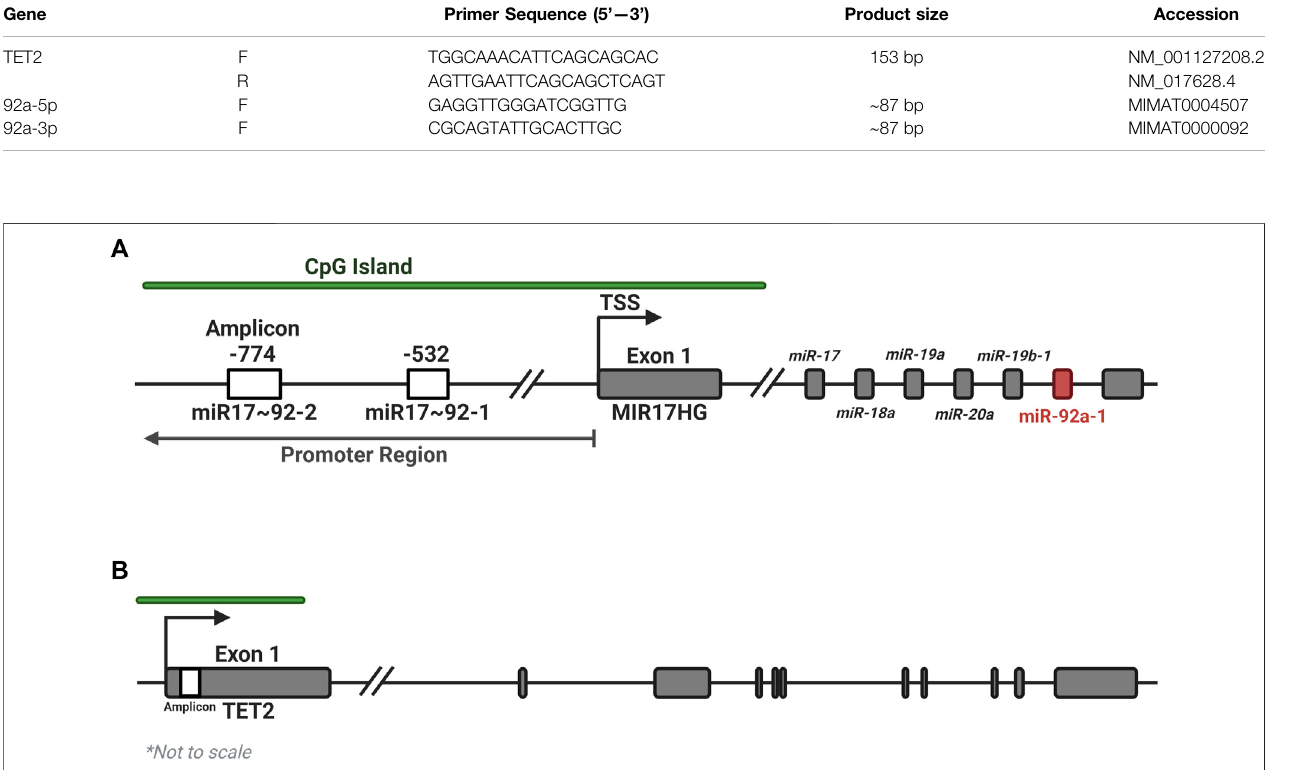
FIGURE 1 | Location of amplicons for the MIR17HG and TET2 methylation assays. Two regions of four CpGs each were identi fi ed within the promoter CGI of the MIR17HG gene (A) , and one region in the fi rst exon of the TET2 gene (B) , each containing several regulatory motifs and transcription factor binding sites. Created with